Question: What visual encoding does this figure use to show its data?
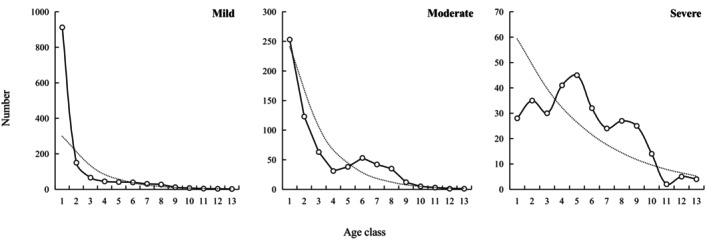
Answer: survival